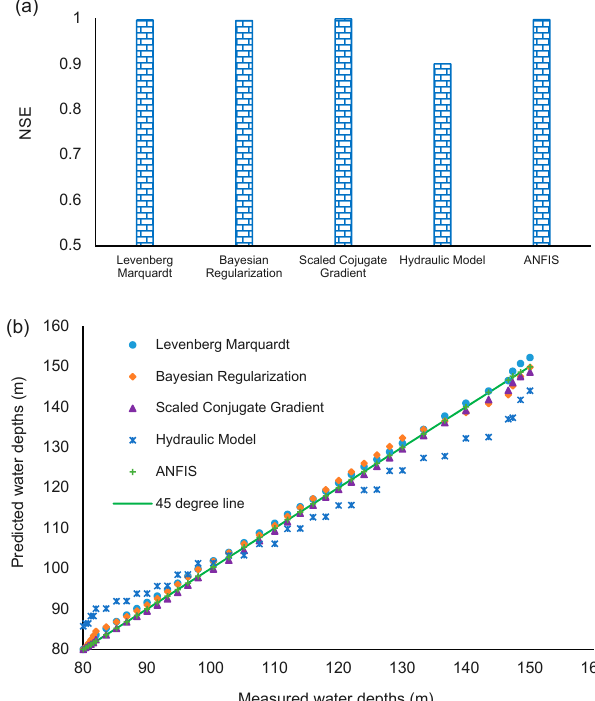
Figure 12. Comparison of the ANN and Hydraulic model. ( a ) NSE ( b ) Groundwater depths.